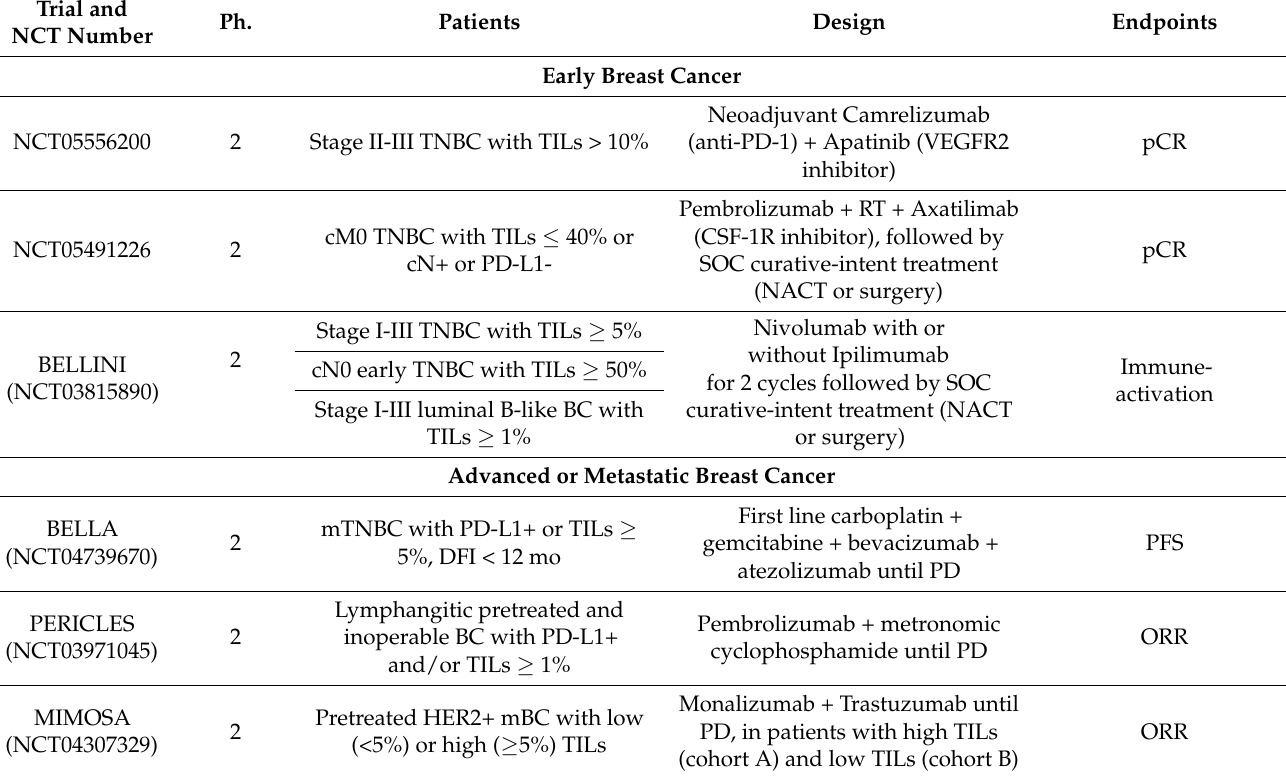
Table 2. Clinical trials assessing the clinical utility of TILs in breast